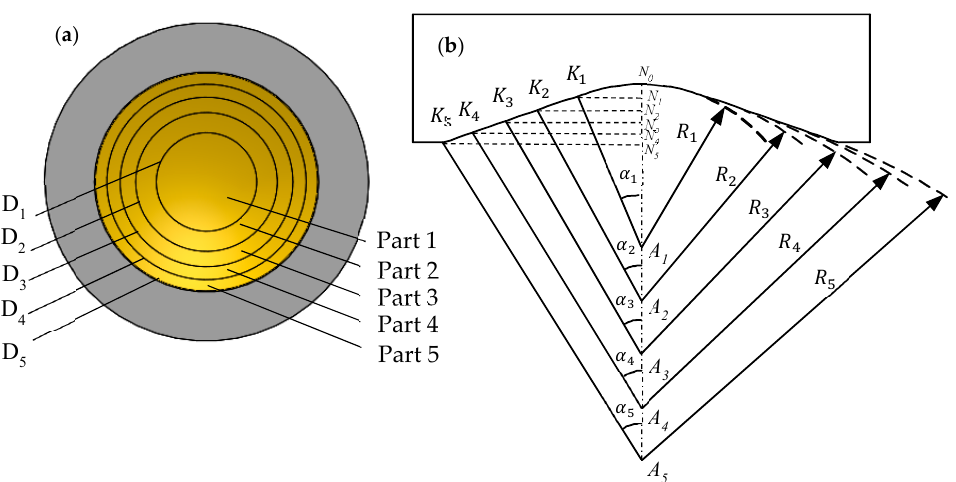
Figure 2. ( a ) The front face of MFP transducer is constructed from five equal area parts of five different spheres. ( b ) The profile of MFP transducer surface.